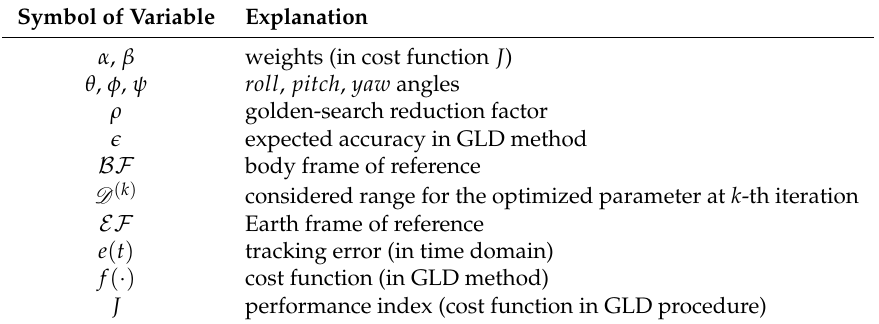
Table 1. Symbols used in this